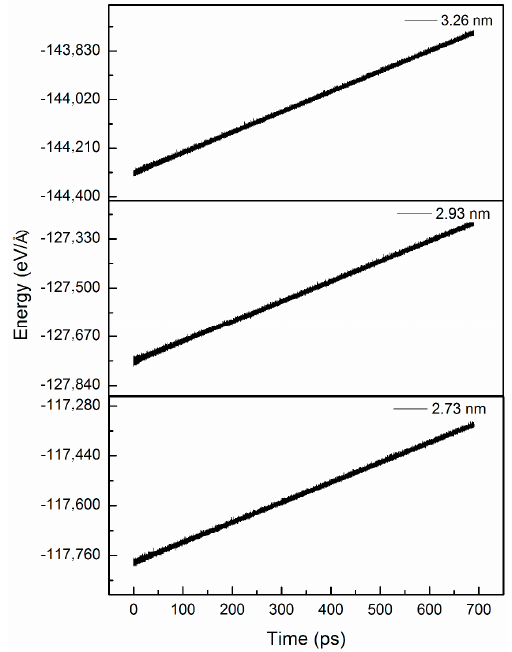
Figure 5. Variation of interaction energy with time for three outer shell diameters.